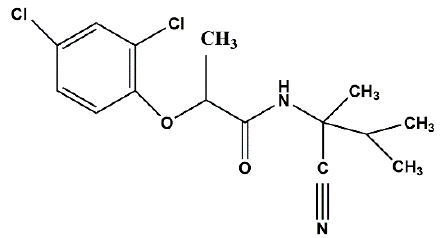
Figure 1. Structure of Fenoxanil.